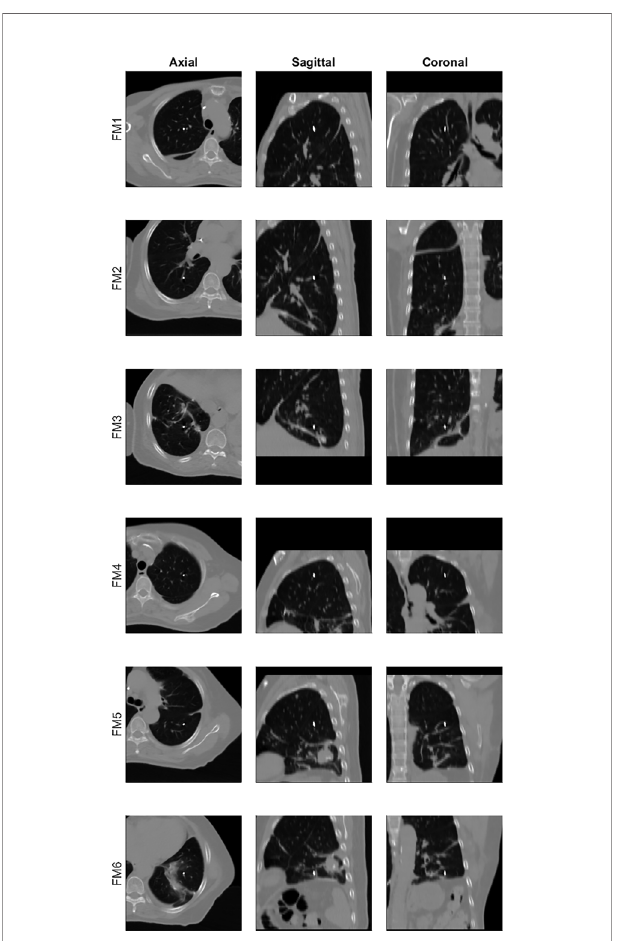
FIGURE 1 | Example of intraoperatively implanted fi ducial markers (six markers for patient 14), each of which is displayed at the center of the axial ( fi rst column from left), sagittal (second), and coronal (third)